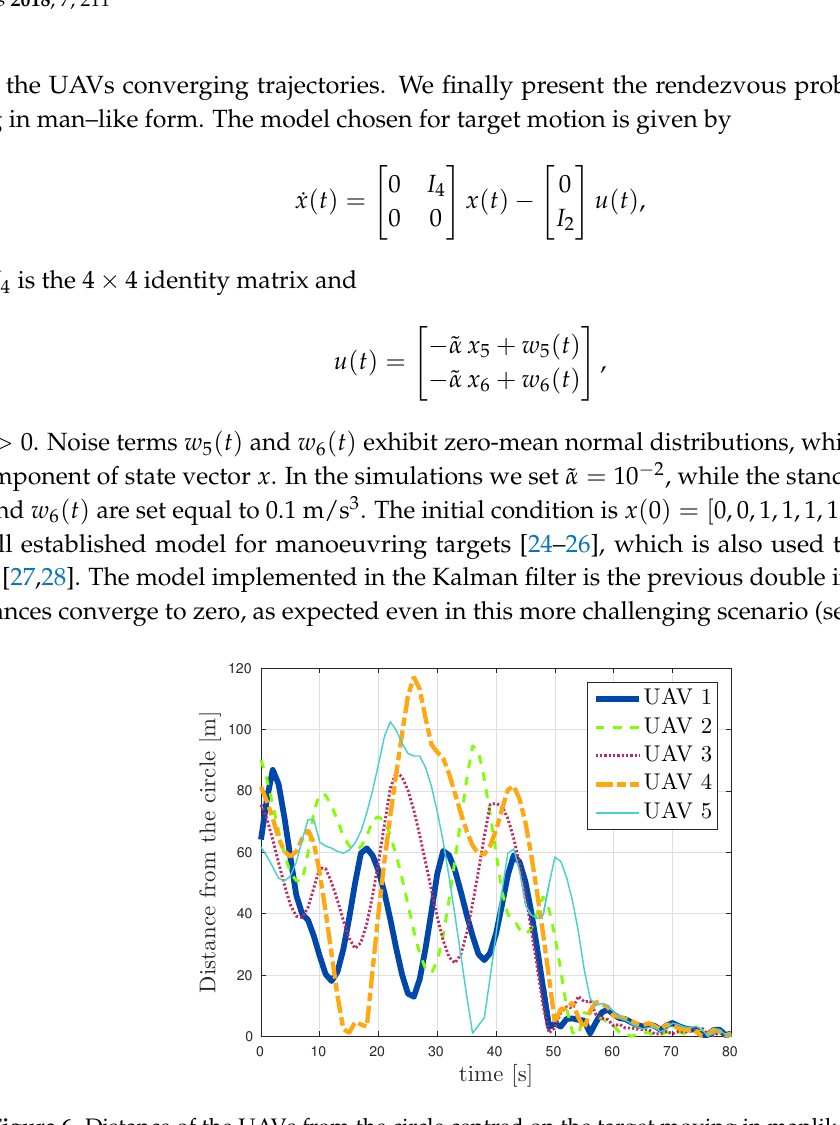
Figure 6. Distance of the UAVs from the circle centred on the target moving in manlike form